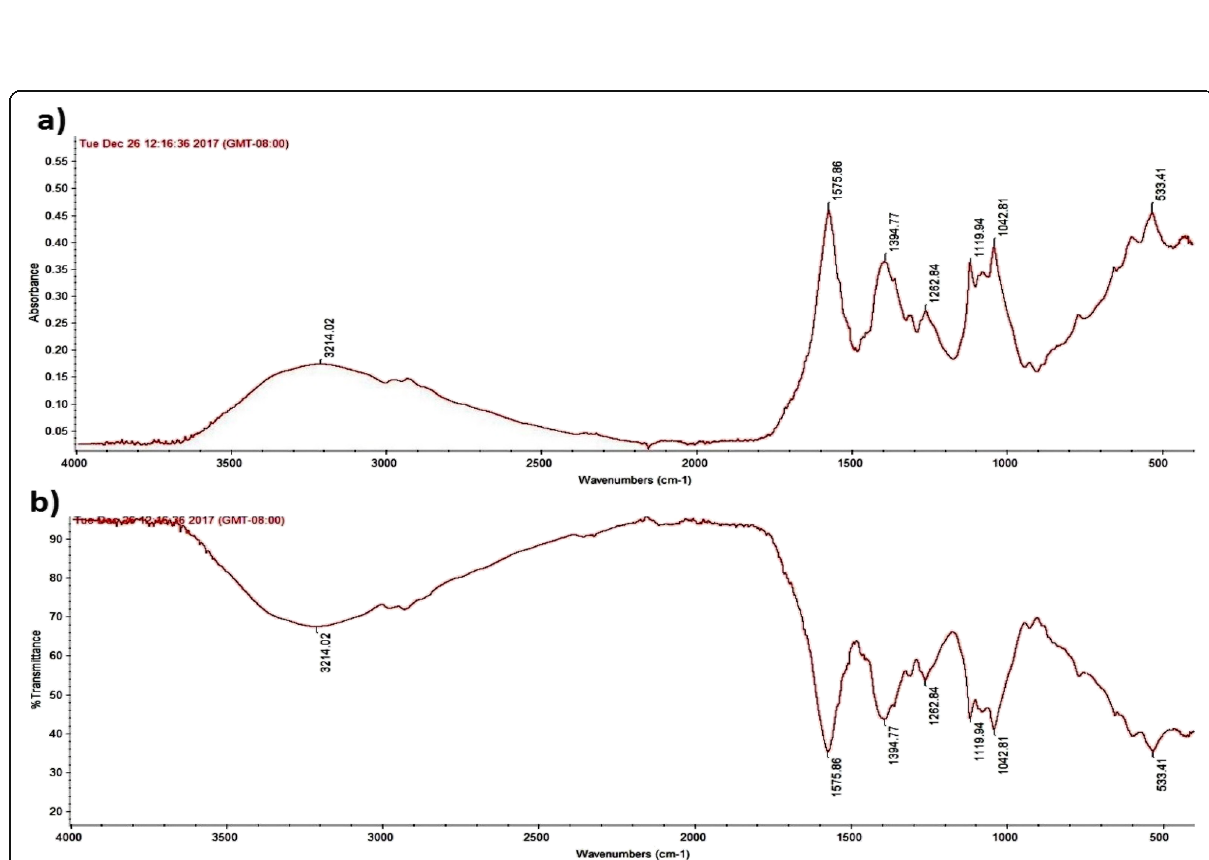
Fig. 2 The FT-IR showing a absorbance and b transmittance of the bioactive compounds in the M. oleifera leaves extract before incorporating